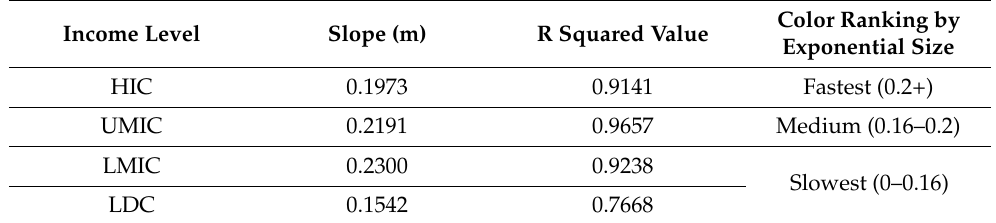
Table 6. Logarithmic linear regression slope and R squared values for each income level in relation to the trend analysis of the article records from 1990–2020. Income Level Slope (m) R Squared Value